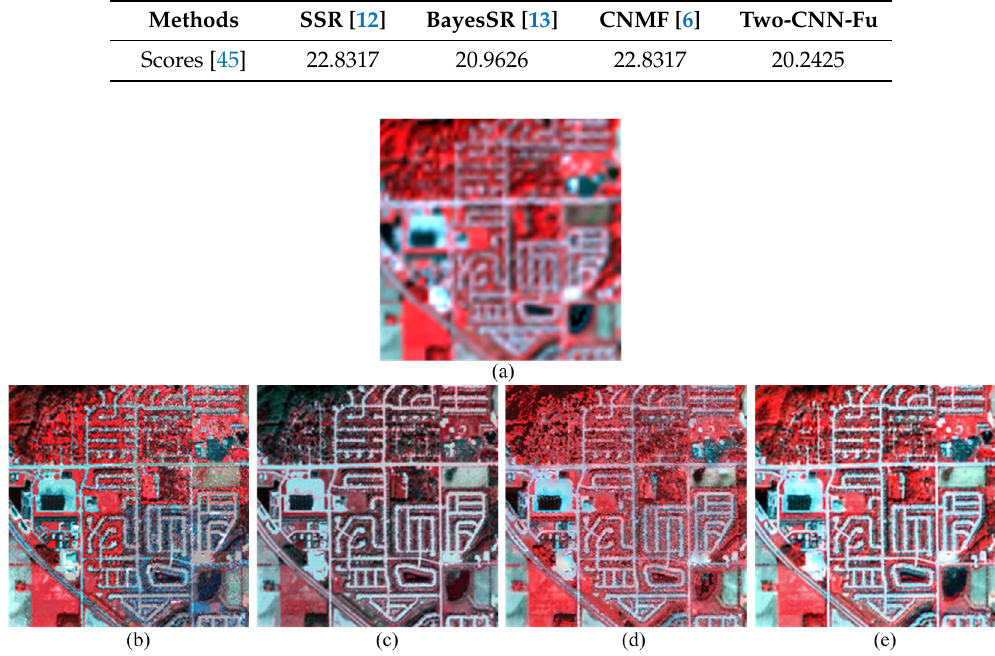
Figure 11. False color composite (bands 45, 21, 14) of the enlarged area in the blue box of Figure 10, size of the area is 200 × 200, ( a ) the original 30 m Hyperion data; ( b ) fusion result of SSR [12]; ( c ) fusion result of BayesSR [13]; ( d ) fusion result of CNMF [6]; ( e ) fusion result of Two-CNN-Fu.